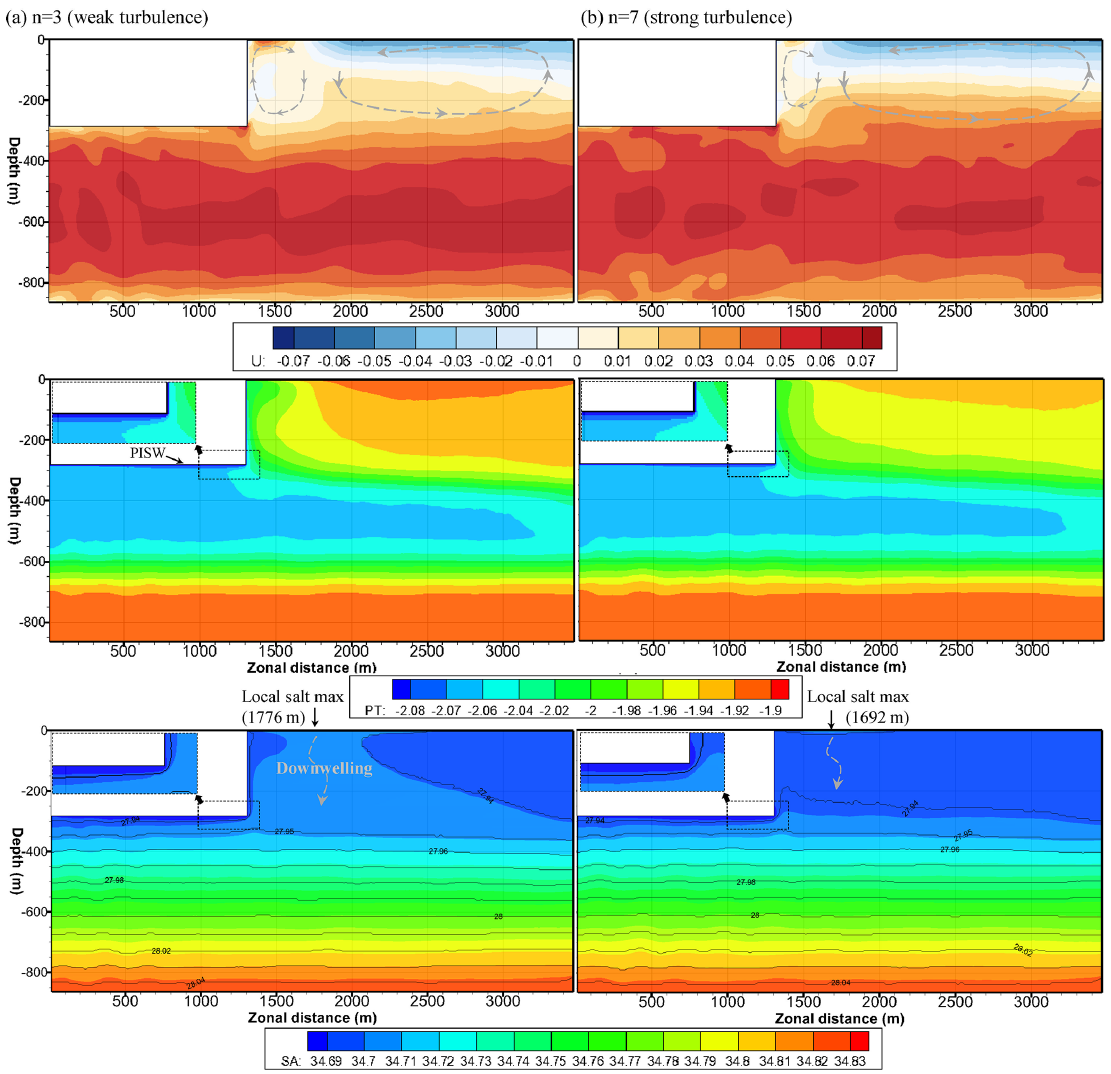
Figure 3. XZ cross-sectional contours ( y = 1728m, domain center) of the zonal velocity, potential temperature, and salinity in the n = 3 (left) and n = 7 (right) cases. In these contours, the zonal direction is perpendicular to the ice-shelf front. These results are time-averaged in the last 3 t ∗ period. Upper row: zonal velocity; middle row: potential temperature; lower row: salinity. In the lower row, the isopycnal lines are identified by the potential density (kgm − 3 ) with 0.01